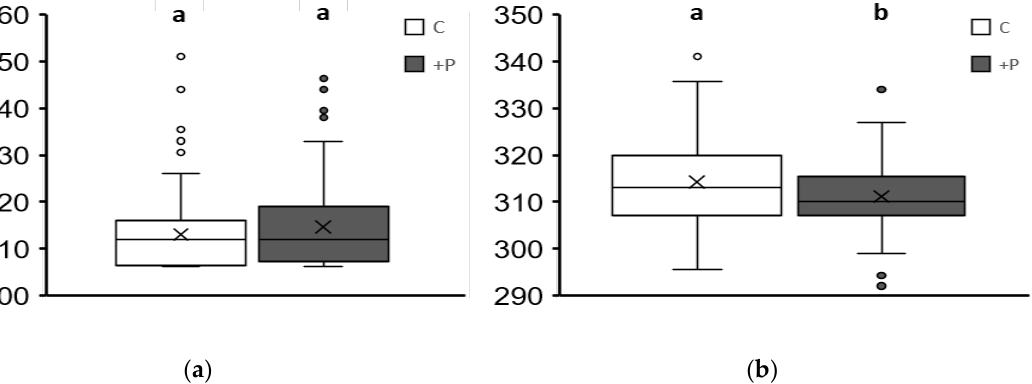
Figure 1. ( a ) Bud-burst date distribution by treatment in the first experimental year (2021). ( b ) Leaf senescence date distribution by treatment in the first experimental year. +P treatment—elevated phosphorus; C—control with no phosphorus added. Different letters denote a statistically significant difference between the two treatments (at p < 0.05).